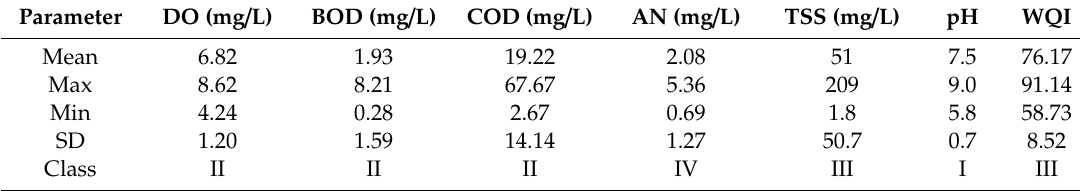
Table 8. Summary of the input and output parameters for the wet season.